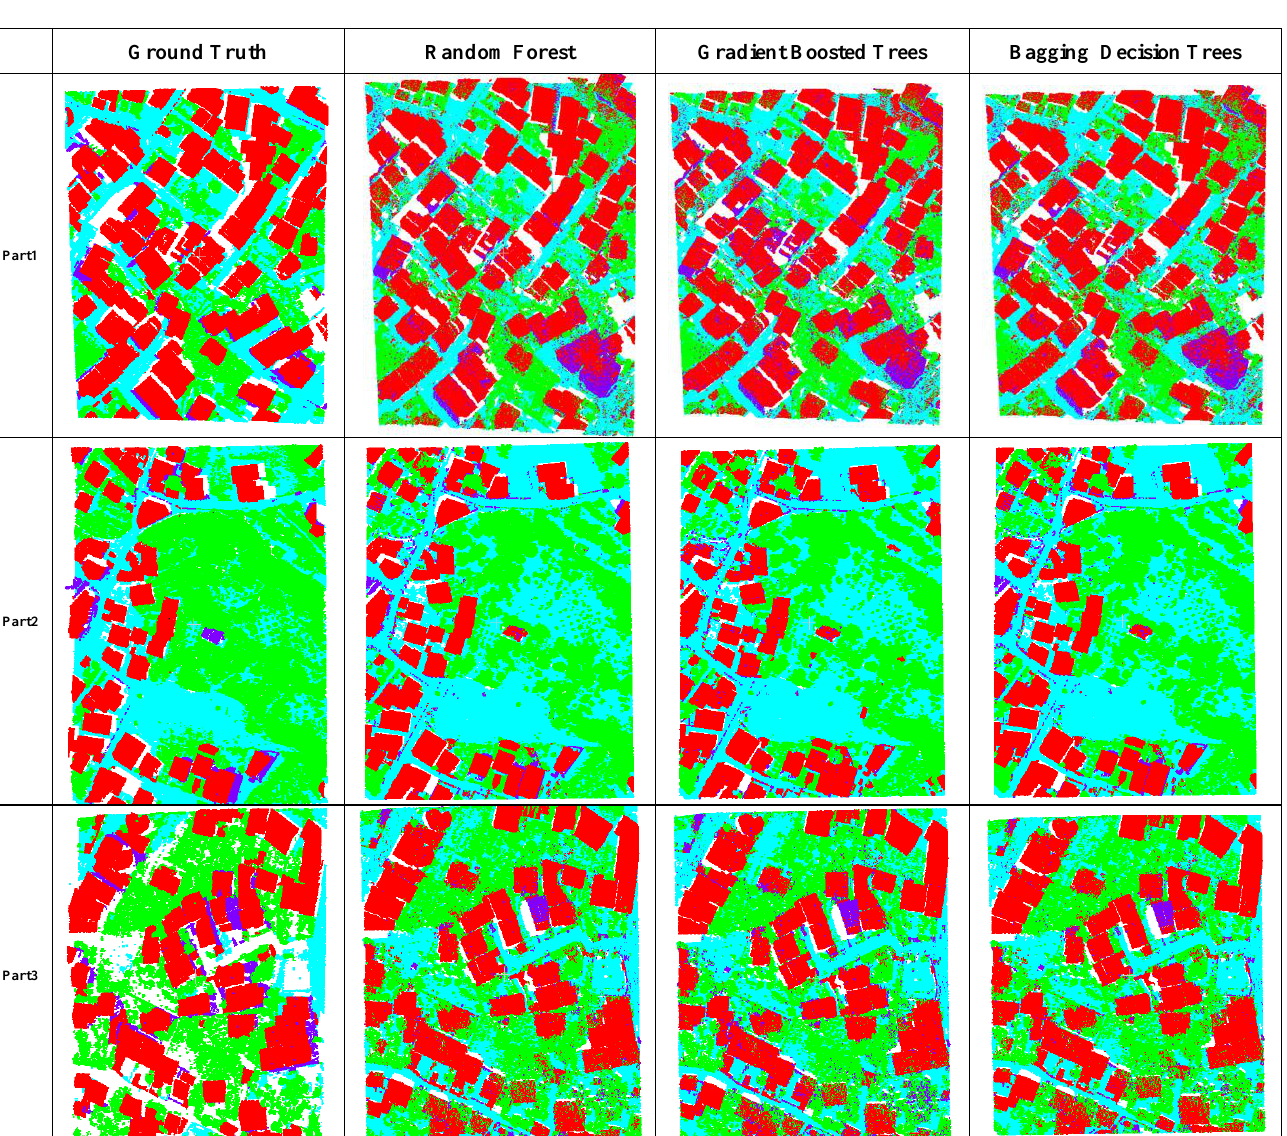
Figure 6 . Visualization results of different parts with three classification methods. (Red: Roof, Green: Tree, Purpule: Wall, Cyan: